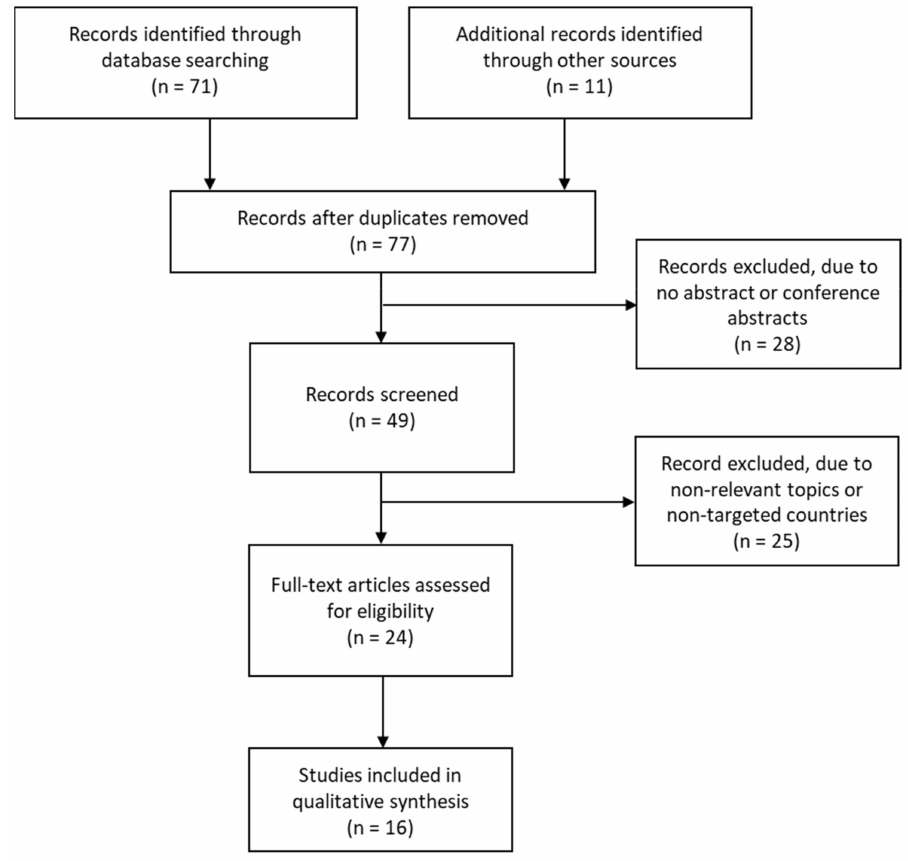
Figure 1. Document-screening